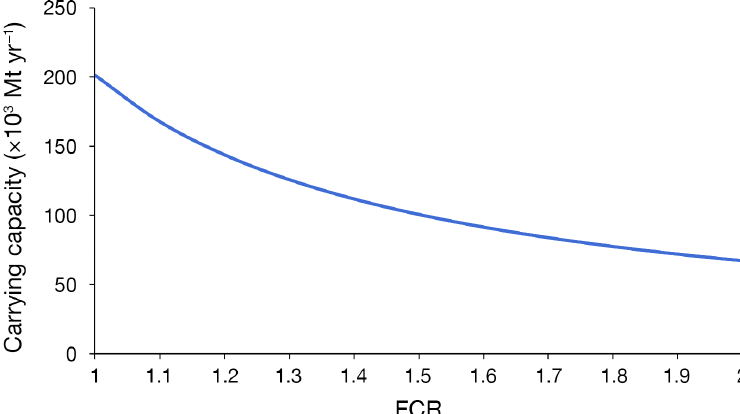
Fig. 8. Carrying capacity of tilapia in Lake Kariba for a range of feed conversion ratios